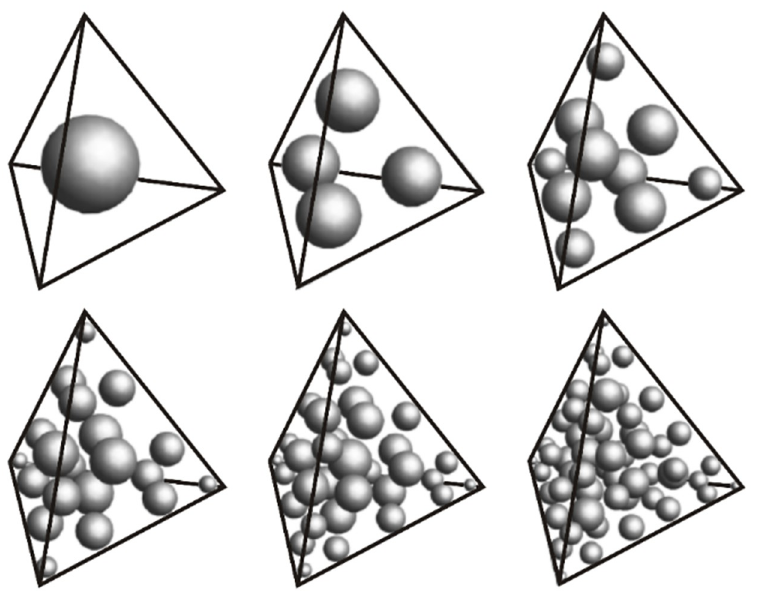
Fig 8. Position and weights of integral points. The size of each sphere represents the relative weight of the quadrature point. First from left to right, then from top to bottom, the integration system with order 1–6, and the total number of integration points are 1, 4, 10, 20, 35 and 56,